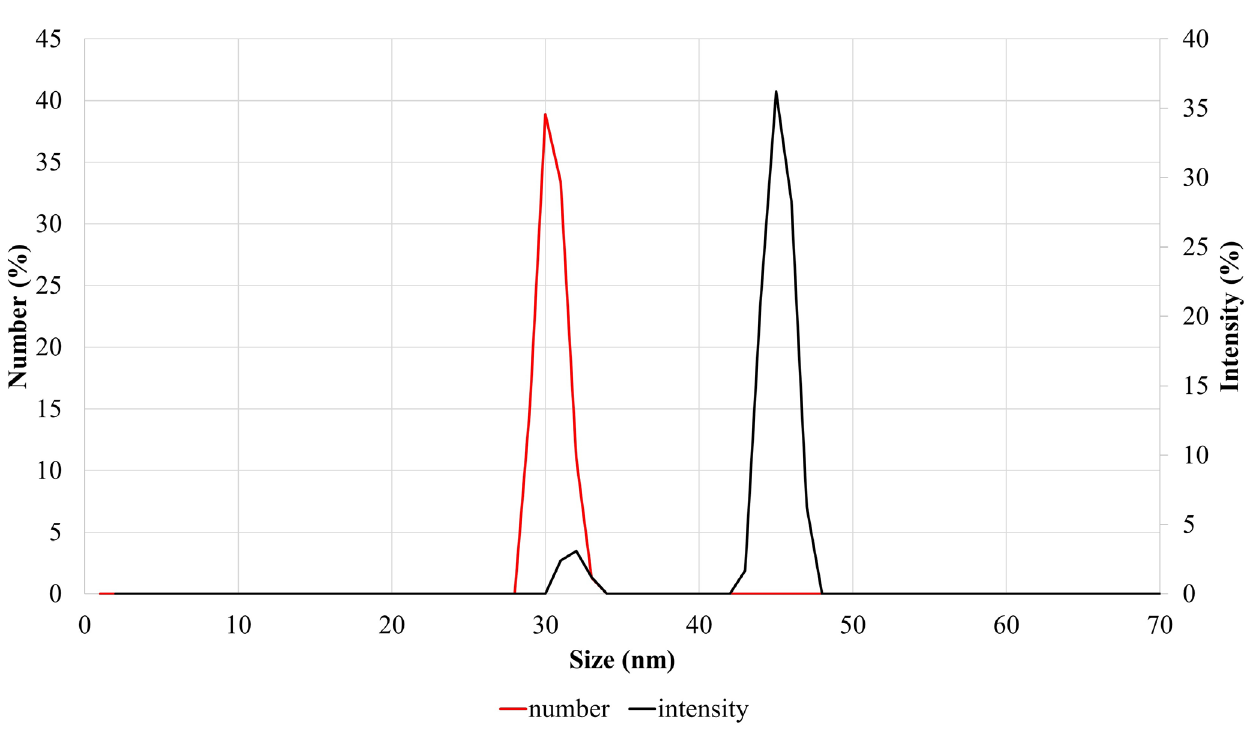
FIGURE 3 - Size distribution of magnetite-chitosan nanobeads with DLS ([Na SO .10H O] = 1.1 wt% ; [chitosan] 2 4 2 final hydrodynamic diameter of magnetite-chitosan nanobeads are 31±2 nm and minor aggregation is suggested around 45 nm.